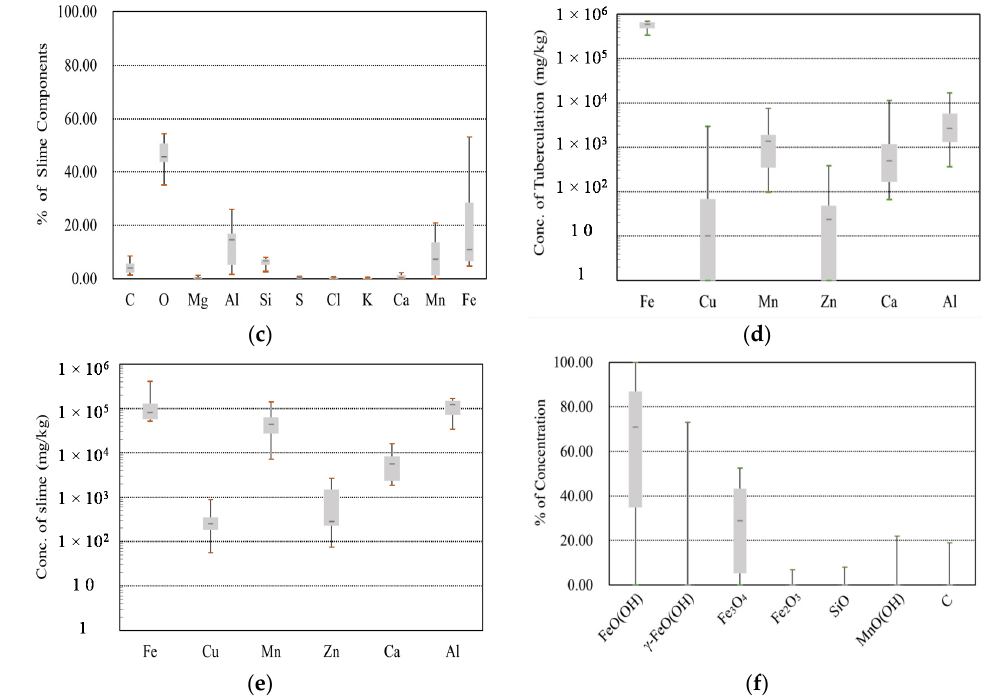
Figure 4. Experimental results for tubercles and slimes. ( a ) VSS (tubercles and slimes); ( b ) SEM-EDS (tubercles); ( c ) SEM-EDS (slimes); ( d ) ICP-MS (tubercles); ( e ) ICP-MS (slimes); ( f ) XRD (tubercles).